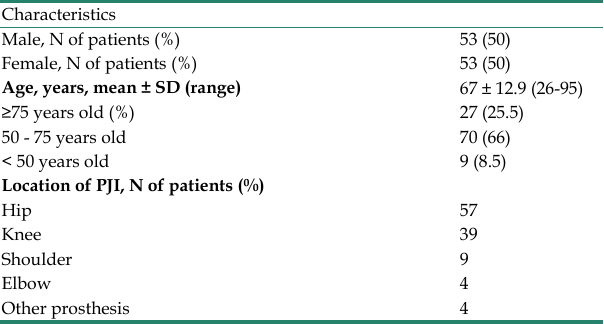
Table 2. Sterile and positive culture of the 216 series of intraoperative samples Columbia agar with blood 5% and chocolate agar with polyvitex : sterile